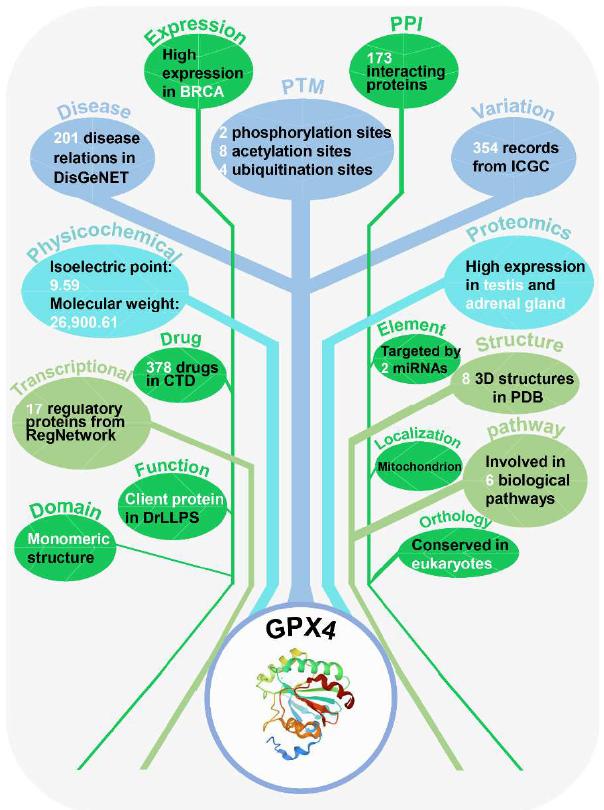
Figure 5. Overview of the 16 aspect annotations information for human GPX4 in the iPCD. The detailed processing for each database is presented in Supplementary Methods, respectively.